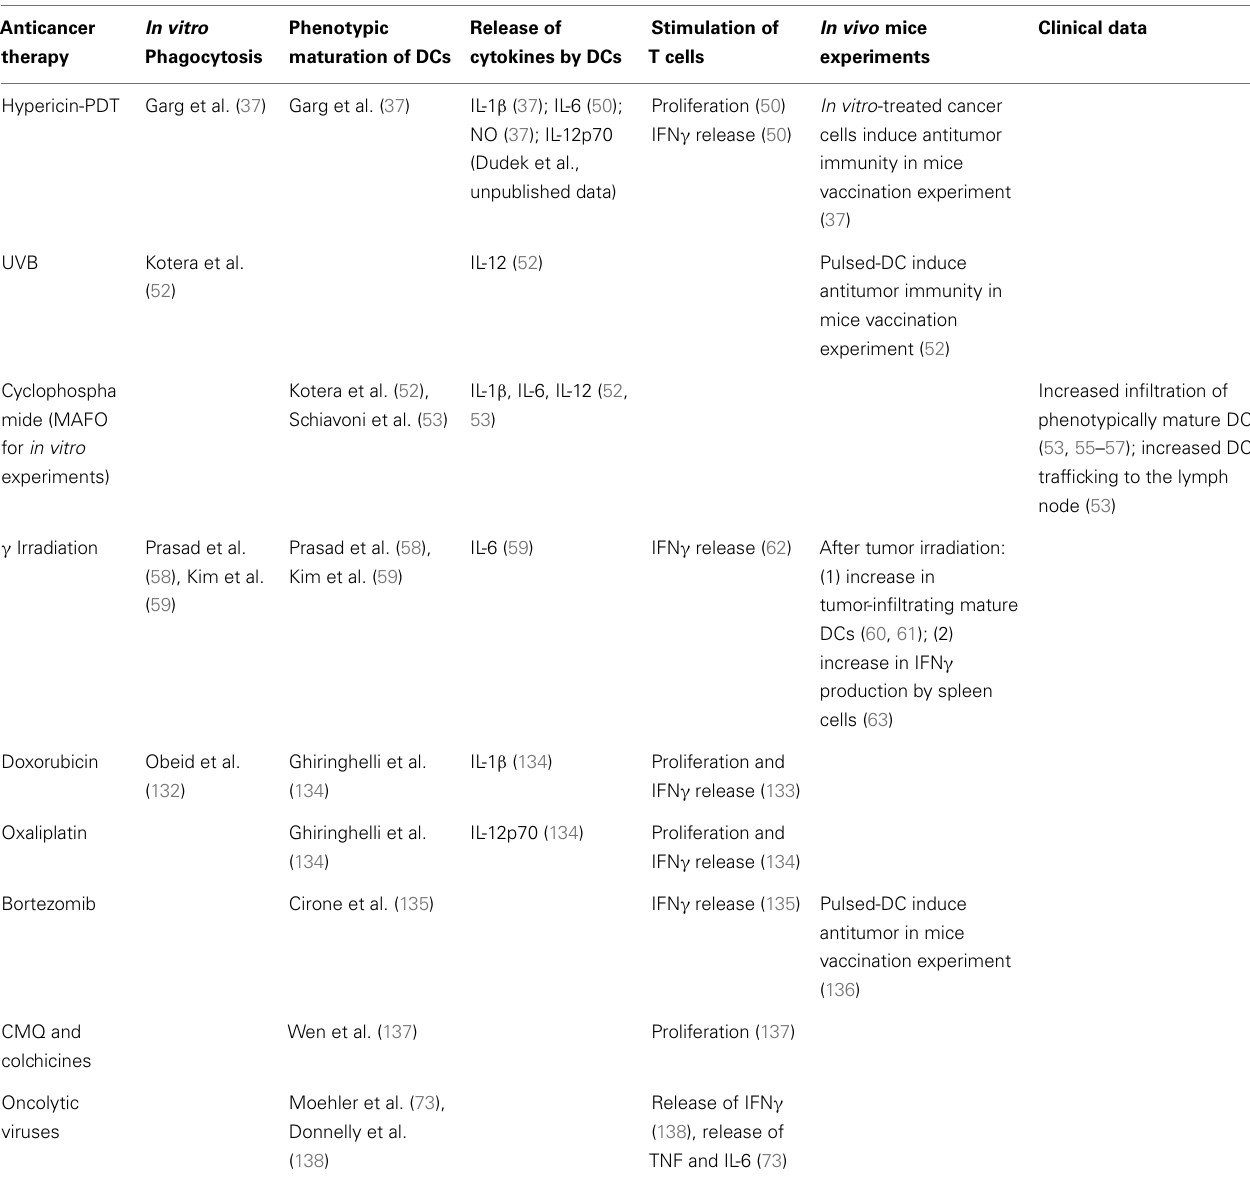
Table 1 | Inducers of cancer cell death that stimulates full maturation of DCs